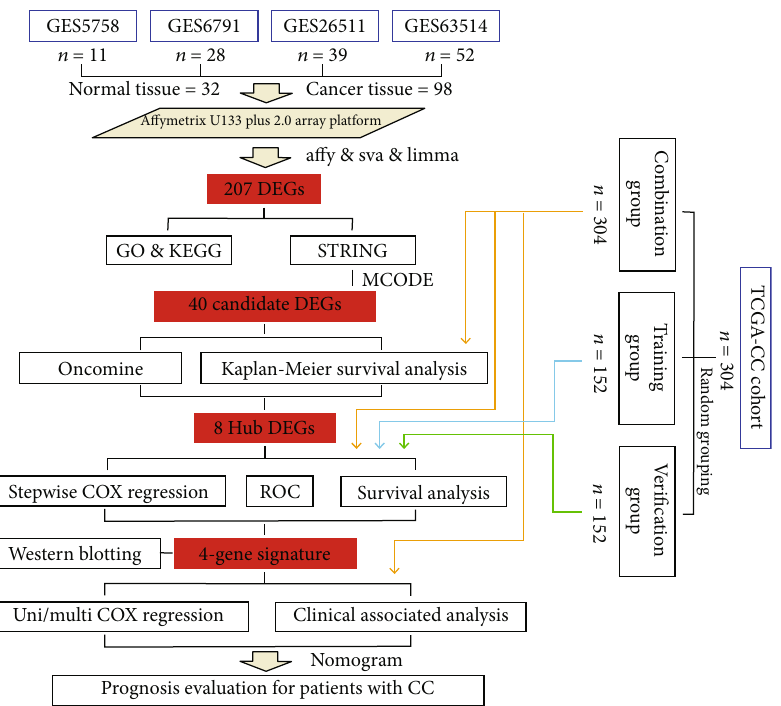
Figure 1: Flow chart of this study. CC: cervical cancer; DEG: di ff erentially expressed gene; ROC: receiver operating